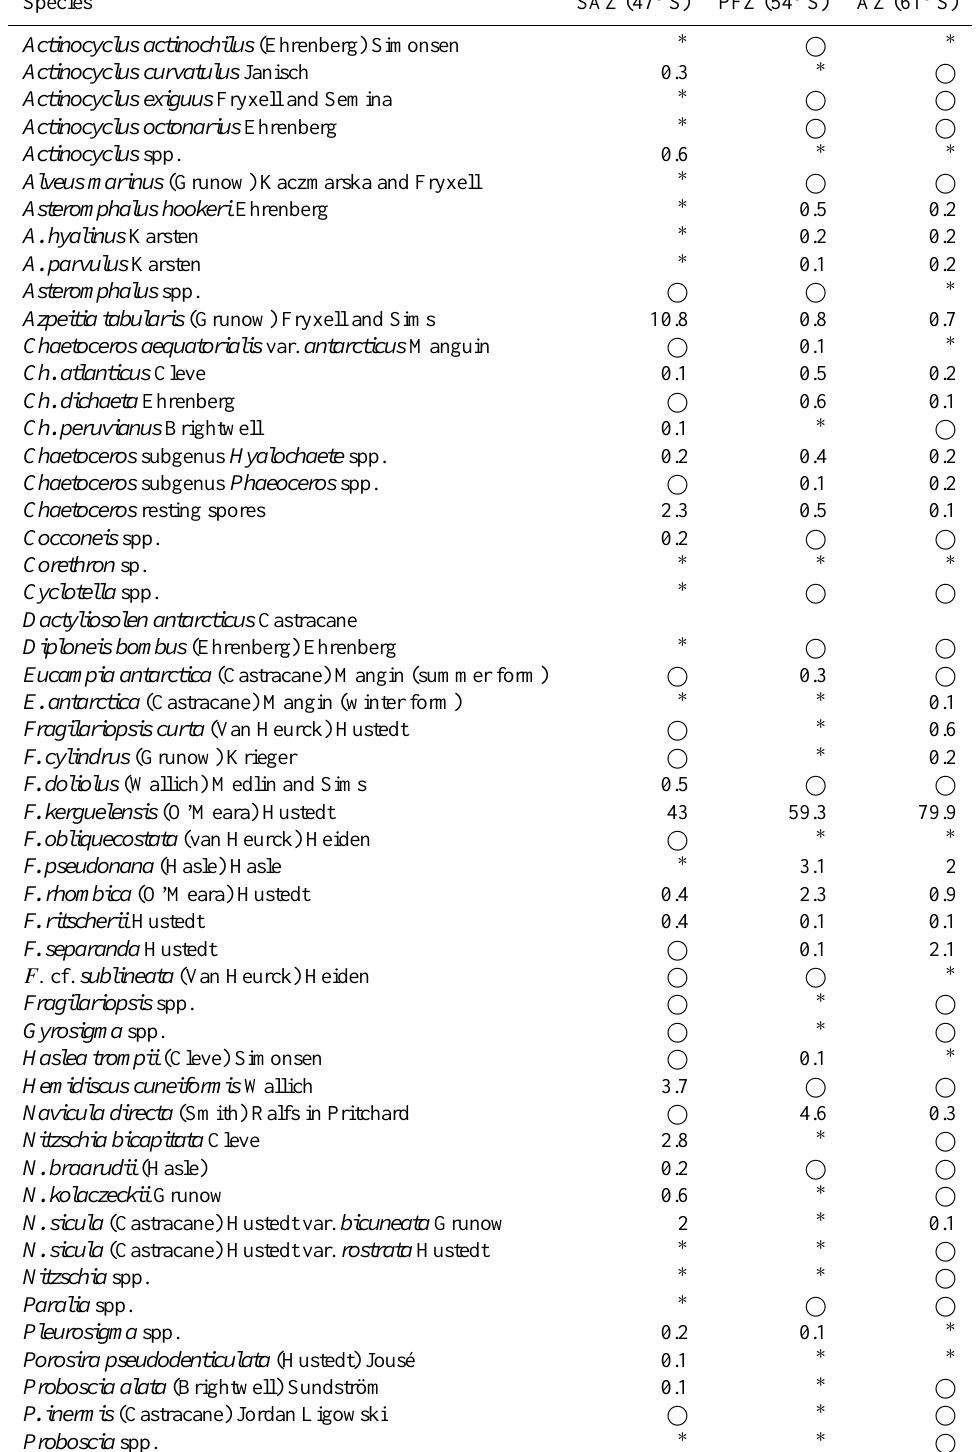
Table 4. List of diatom species recorded in the sediment traps of the 47, 54 and 61 ◦ S (2000m) sites along the 140 ◦ E. Relative abundances <0.1 are represented by an asterisk ( ∗ ), whereas the absence of a taxon in a given site is represented by an empty circle ( (cid:13) ).